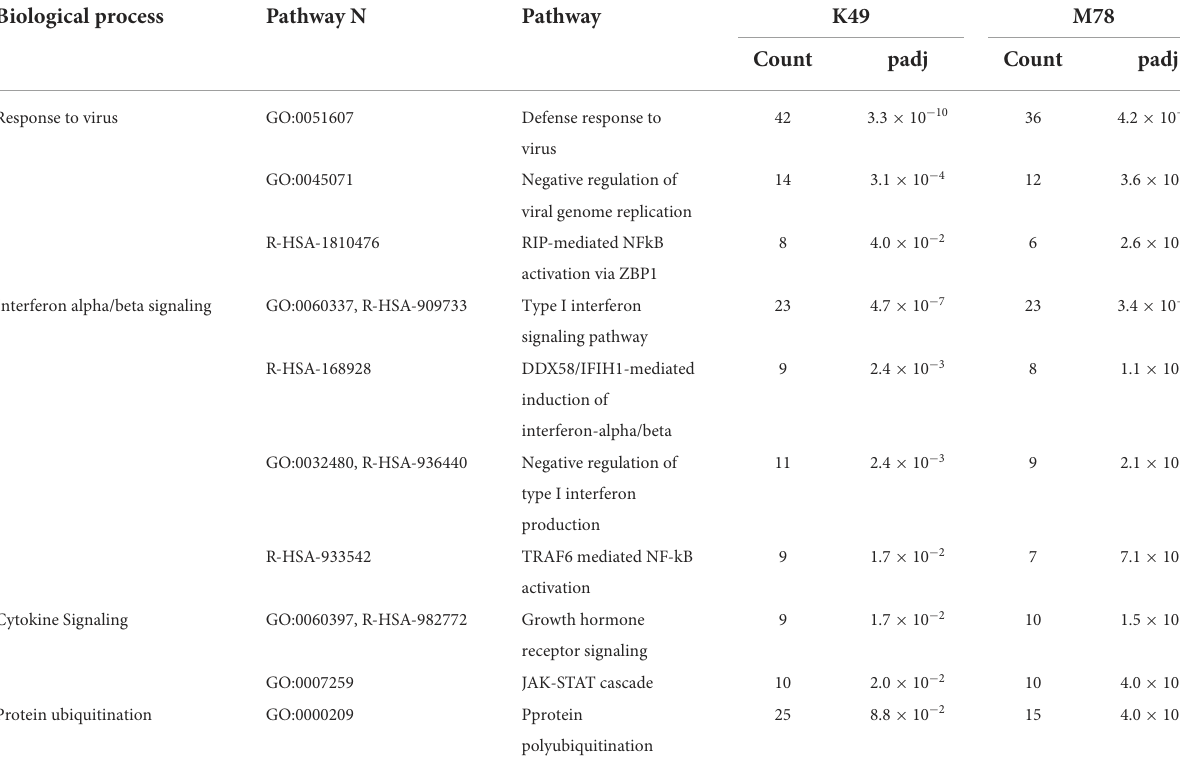
TABLE 2 Biological pathways with up-regulated genes in PBMCs infected with both K49 and M78 strains (FDR ≤ 0.05). Biological